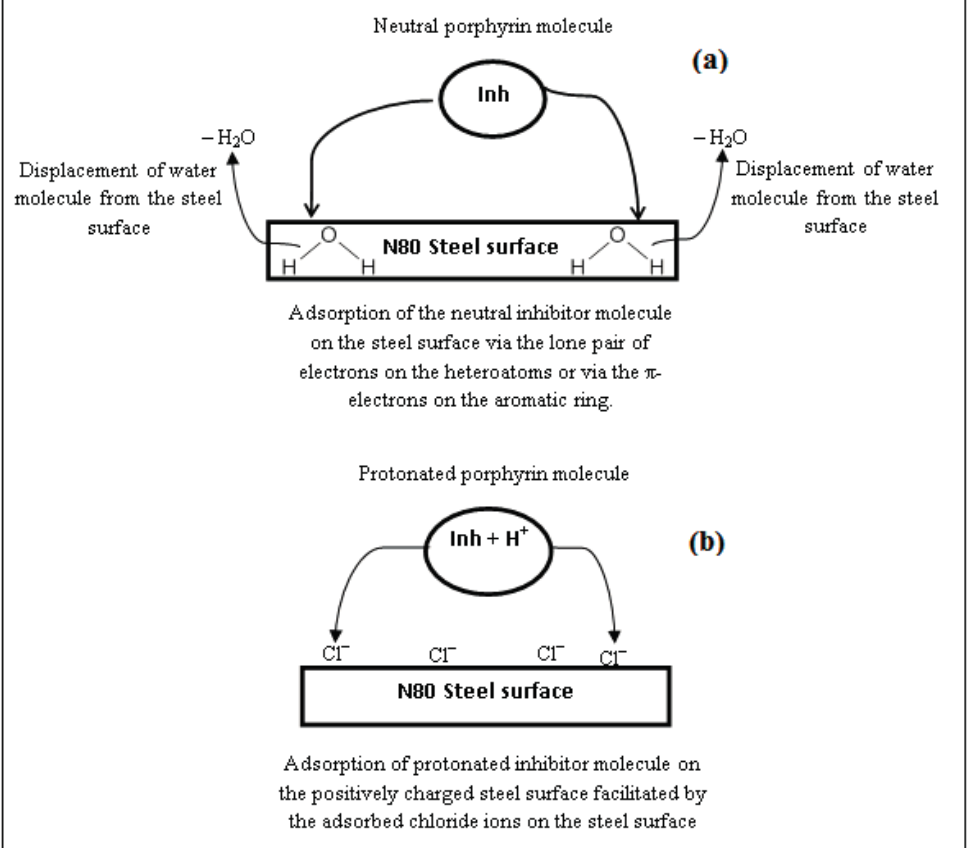
Figure 12. Possible mechanism of adsorption of the studied porphyrin molecules on the N80 steel